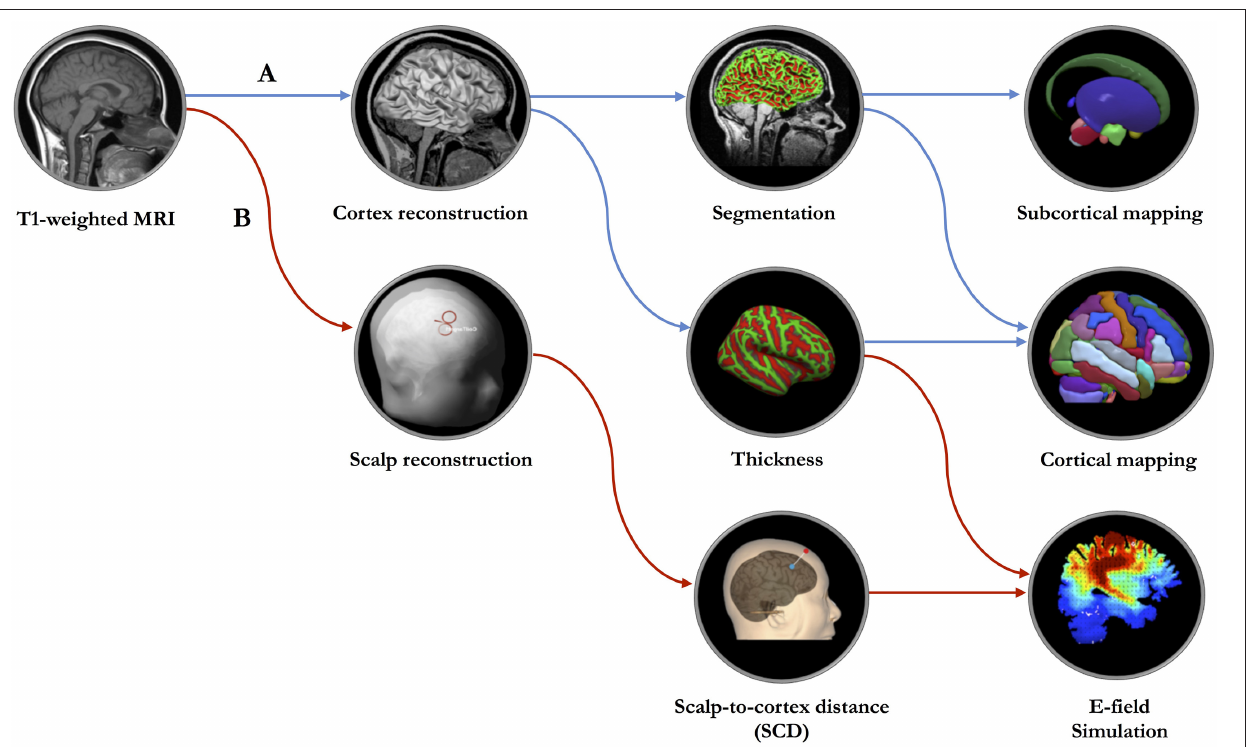
FIGURE 1 | The proposed geometric model of network-based transcranial brain stimulation. (A) Based on high-resolution T1-weighted structural MRI data, surface-based morphometry analysis will be performed to measure the cortical and subcortical structures. (B) MRI data will be imported to the neuronavigation system for constructing scalp and cerebral cortex, localizing the targeted cortical regions, measuring the scalp-to-cortex distance (SCD) and establishing the simulation model of SCD-dependent electric field